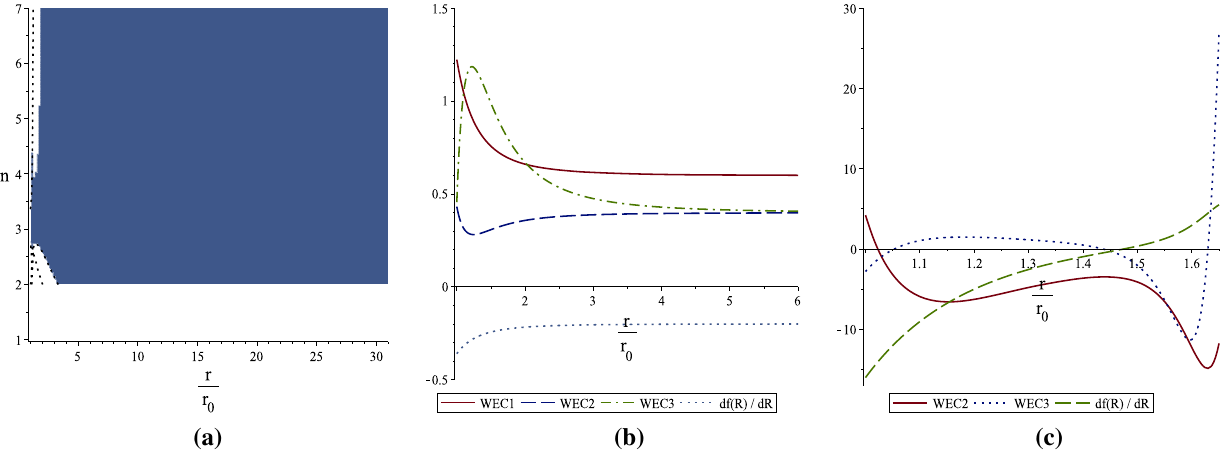
Fig. 11 a Shows that the asymptoticly hyperbolic wormholes with n > 2 in the Nojiri–Odintsov model, respect the WEC almost through